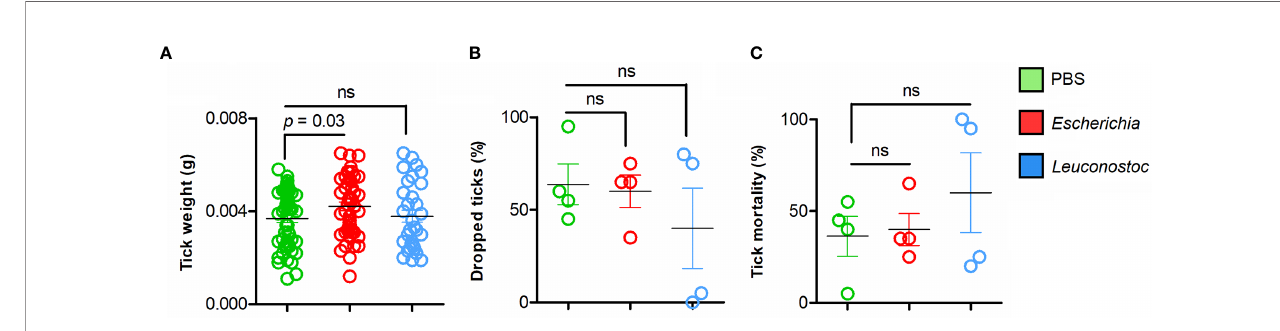
FIGURE 2 | Performance of I. ricinus nymphs feeding on mice vaccinated with live E. coli or L. mesenteroides. (A) The weight of individual engorged ticks was measured and compared between groups. (B) The percentage of ticks that engorged and dropped was calculated and compared between groups. (C) The percentage of dead ticks was calculated and tick mortality (%) was compared between groups. Means and standard deviation values are displayed. The parameters were compared between groups by the Mann-Whitney U test. (ns-not signi fi cant; n = 12 mice, n = 20 ticks per mouse).